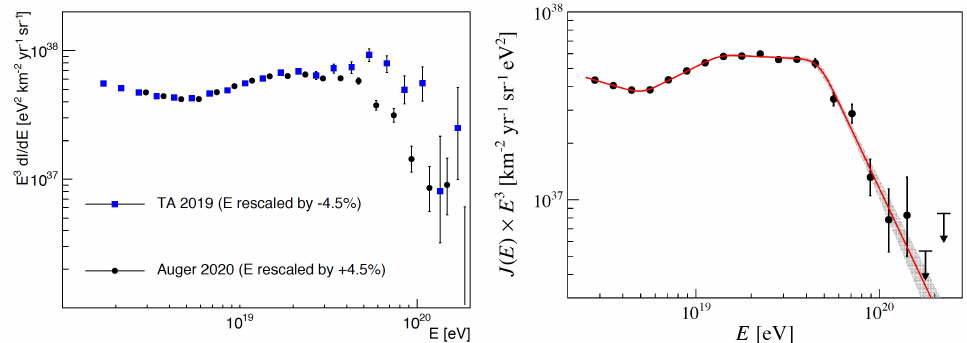
Figure 1. Left: Energy spectrum of UHECRs as measured by the PA (Auger) and TA surface detectors, with each spectrum being adjusted for uncertainties in absolute energy scale by the same amount. Good agreement is achieved up to E ∼ 4 × 10 19 eV. Right: Evidence from PA data for a new spectral feature (“instep”) between 1.5 × 10 19 and 4.5 × 10 19 , also supported by TA data. The observed spectrum can be well fitted by a series of four power-laws. From ref.